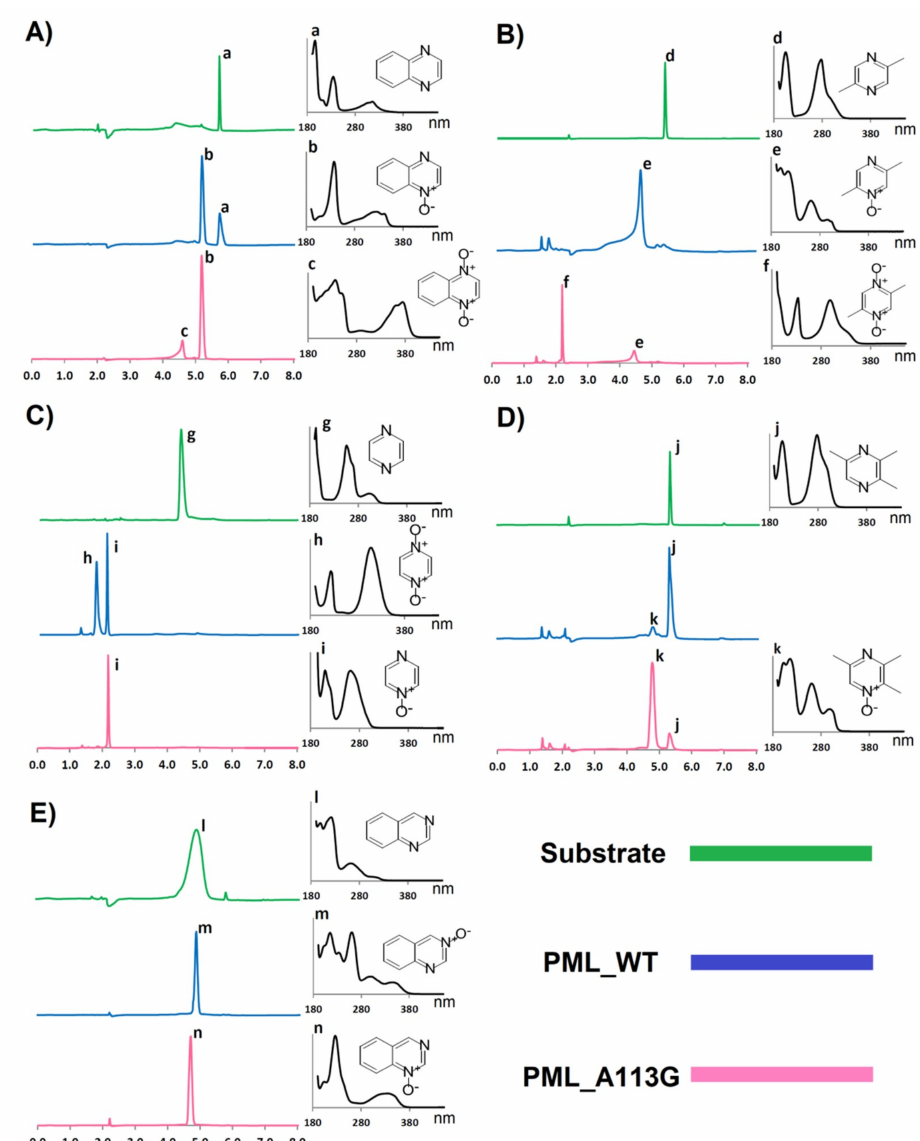
Figure 4. The analysis of the conversion reactions catalyzed by the wild type PML and the A113G mutant. Conversions conducted at 30 ◦ C for 24 h. The initial concentration of substrate was 1.0 mM. The end products were analyzed by high-performance liquid chromatography (HPLC). A ) quinoxaline (345 nm); B ) 2,5-dimethylpyrazine (277 nm); C ) pyrazine (282 nm); D ) 2,3,5-trimethylpyrazine (260 nm); E) quinazoline (320 nm). Lowercase letters relate the appropriate peak in HPLC to its corresponding ultraviolet (UV)